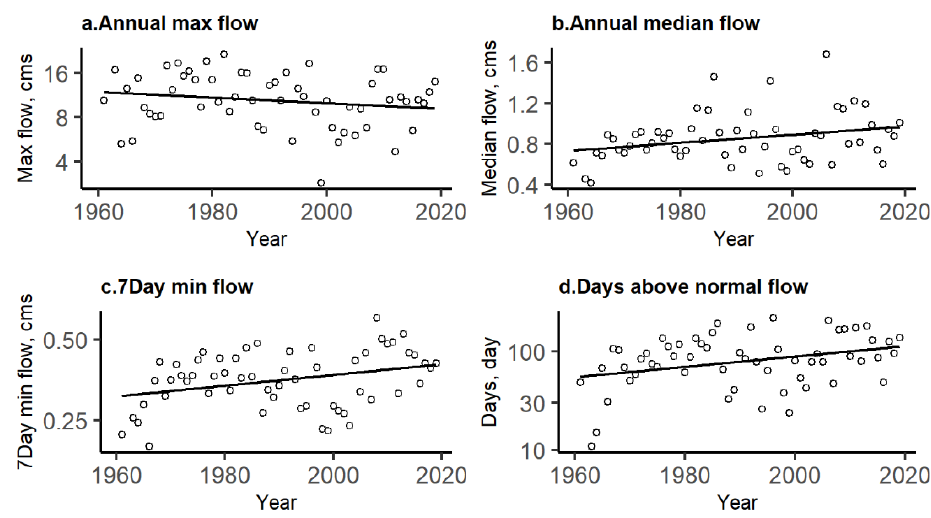
Figure 5. Streamflow regime of the WB Norval (urban) gauge located on a tributary. ( a ) Annual max flow, ( b ) Annual median flow, ( c ) 7-day min flow, ( d ) Days above normal flow.